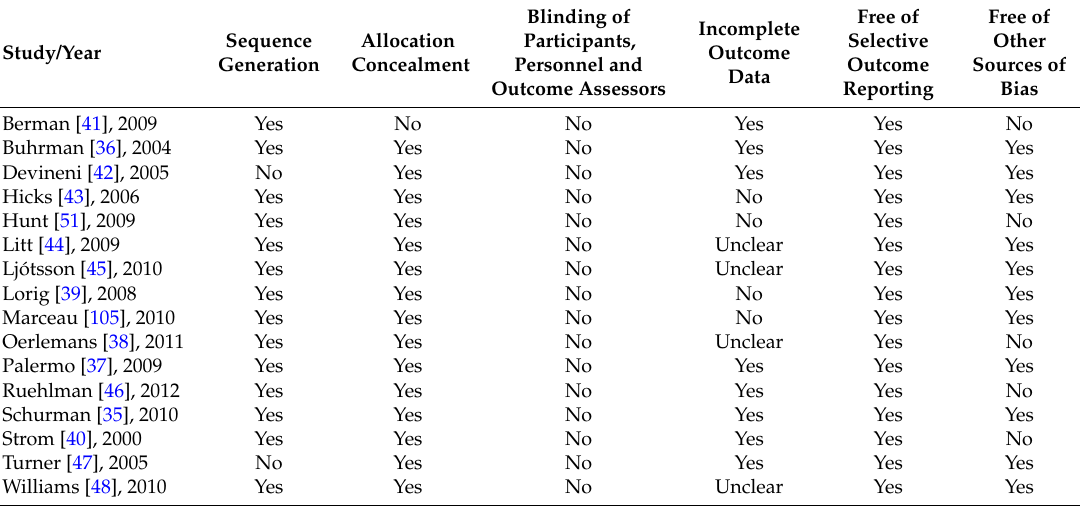
Table A2. Risk of bias